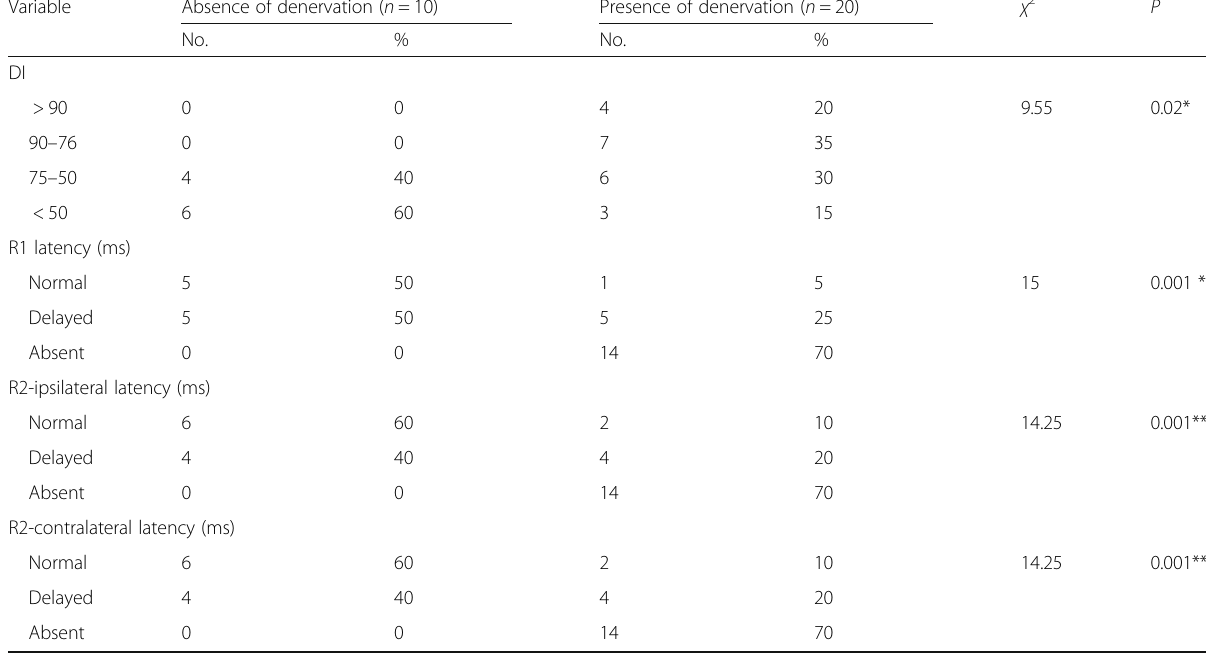
Table 2 Relation between the patterns of abnormal rest potentials detected by needle EMG with the different